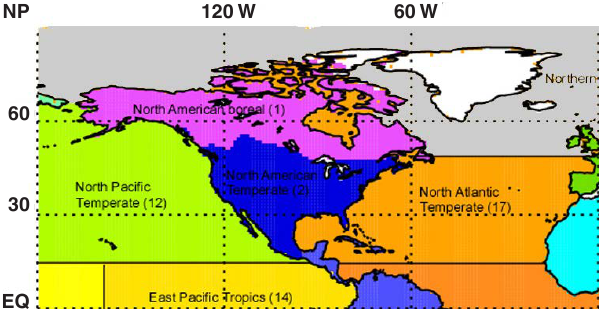
Figure 2. TransCom3 regions of the western Northern Hemisphere (Baker et al., 2006). The combined North American Boreal and North American Temperate regions define North America for the atmospheric inversion model (AIM) and terrestrial biosphere model (TBM) approaches to estimating net land–atmosphere carbon ex- change for North America. Adapted from http://transcom.project.